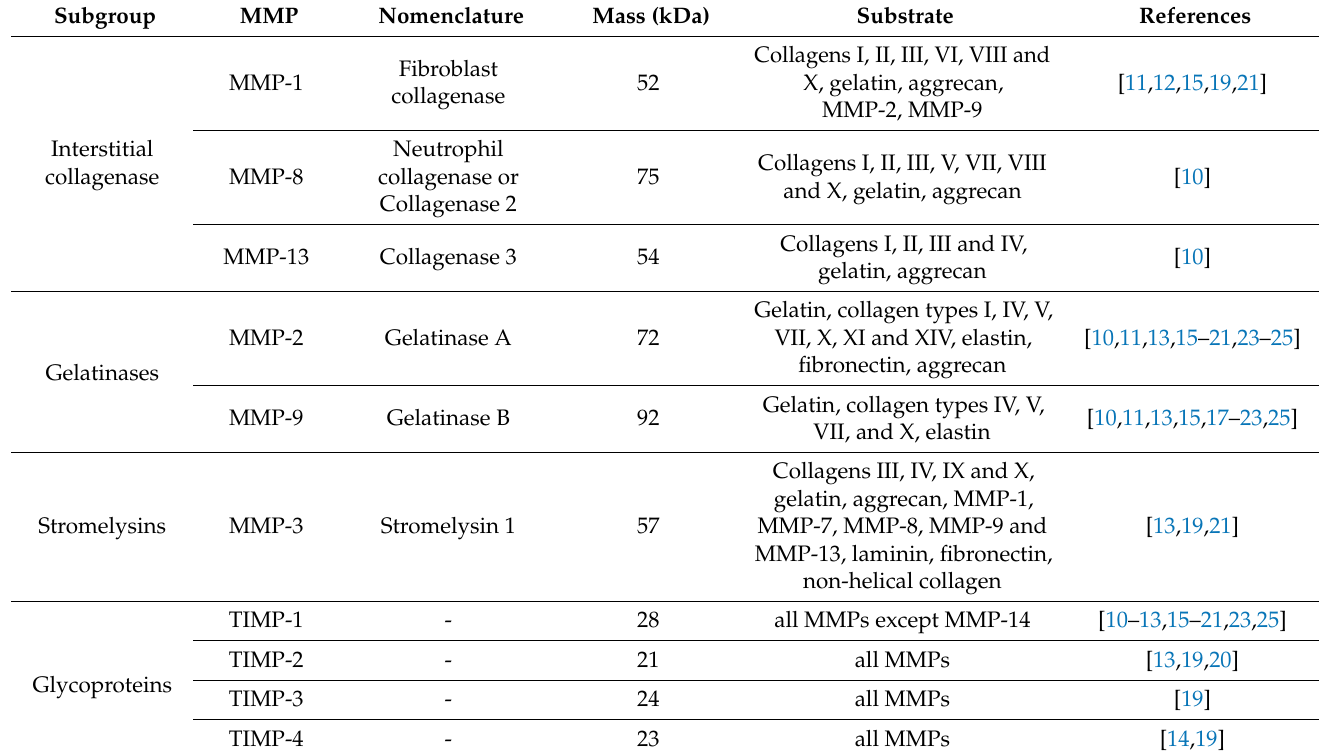
Table 2. Matrix metalloproteinases and tissue inhibitor of matrix metalloproteinases identified in patients with hypertrophic